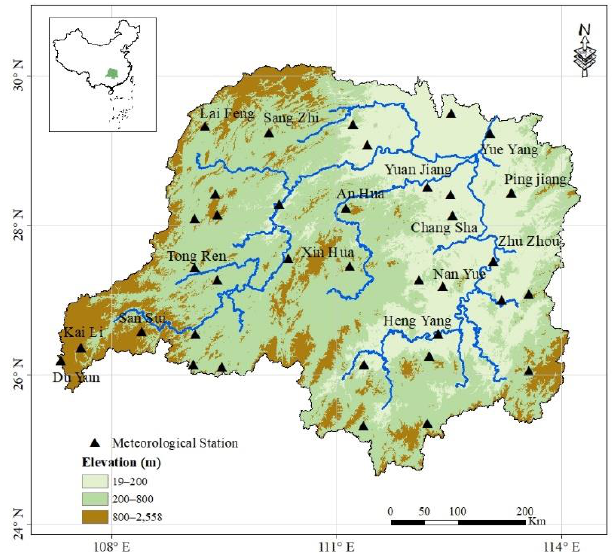
Figure 1. The hydrological and topographic layout of the Dongting Lake basin.